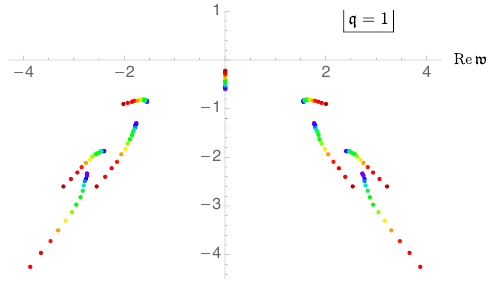
Figure 4. The eight lowest complex quasi- normal modes and the lowest purely imag- inary one in spin 1 channel, at q = 1. Ev- ery colorful path-like set of points, starting in purple and ending in red, shows the change of one speci(cid:12)c mode when Q discretely in- creases from 0 to 0 : 8. We have considered 16 regular steps by increments of (cid:1) Q = 0 :